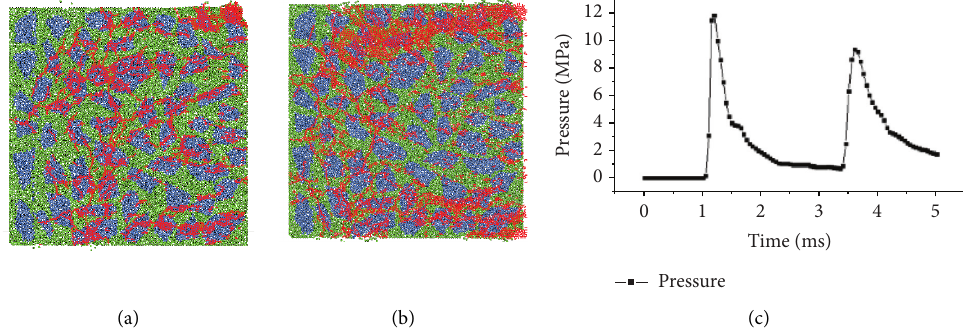
Figure 18: (a) The damage of point B4 at normal temperature, (b) the damage of point B3 at 500K, and (c) the compressive